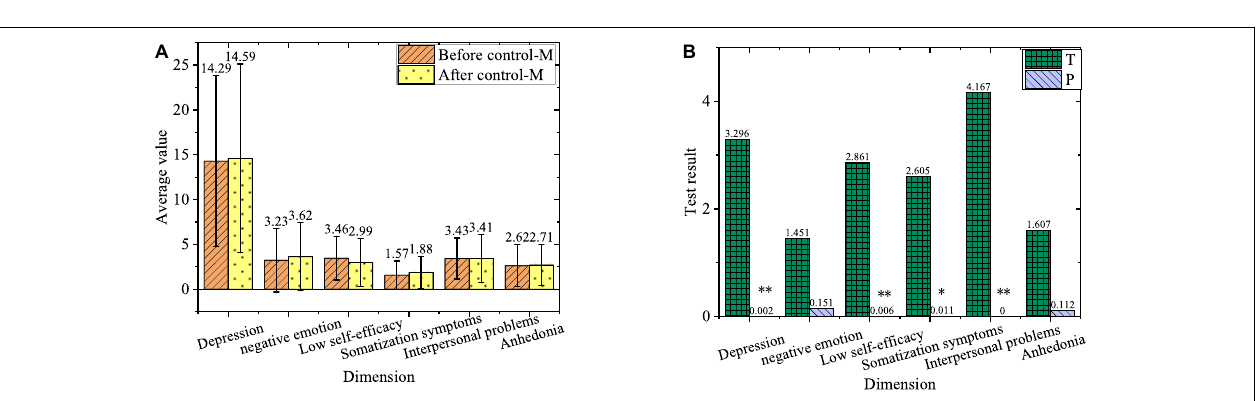
FIGURE 6 | Comparison of negative emotions. (A) Average of female subjects in treatment group and control group. (B) Value of T and P of female subjects in treatment group and control group.